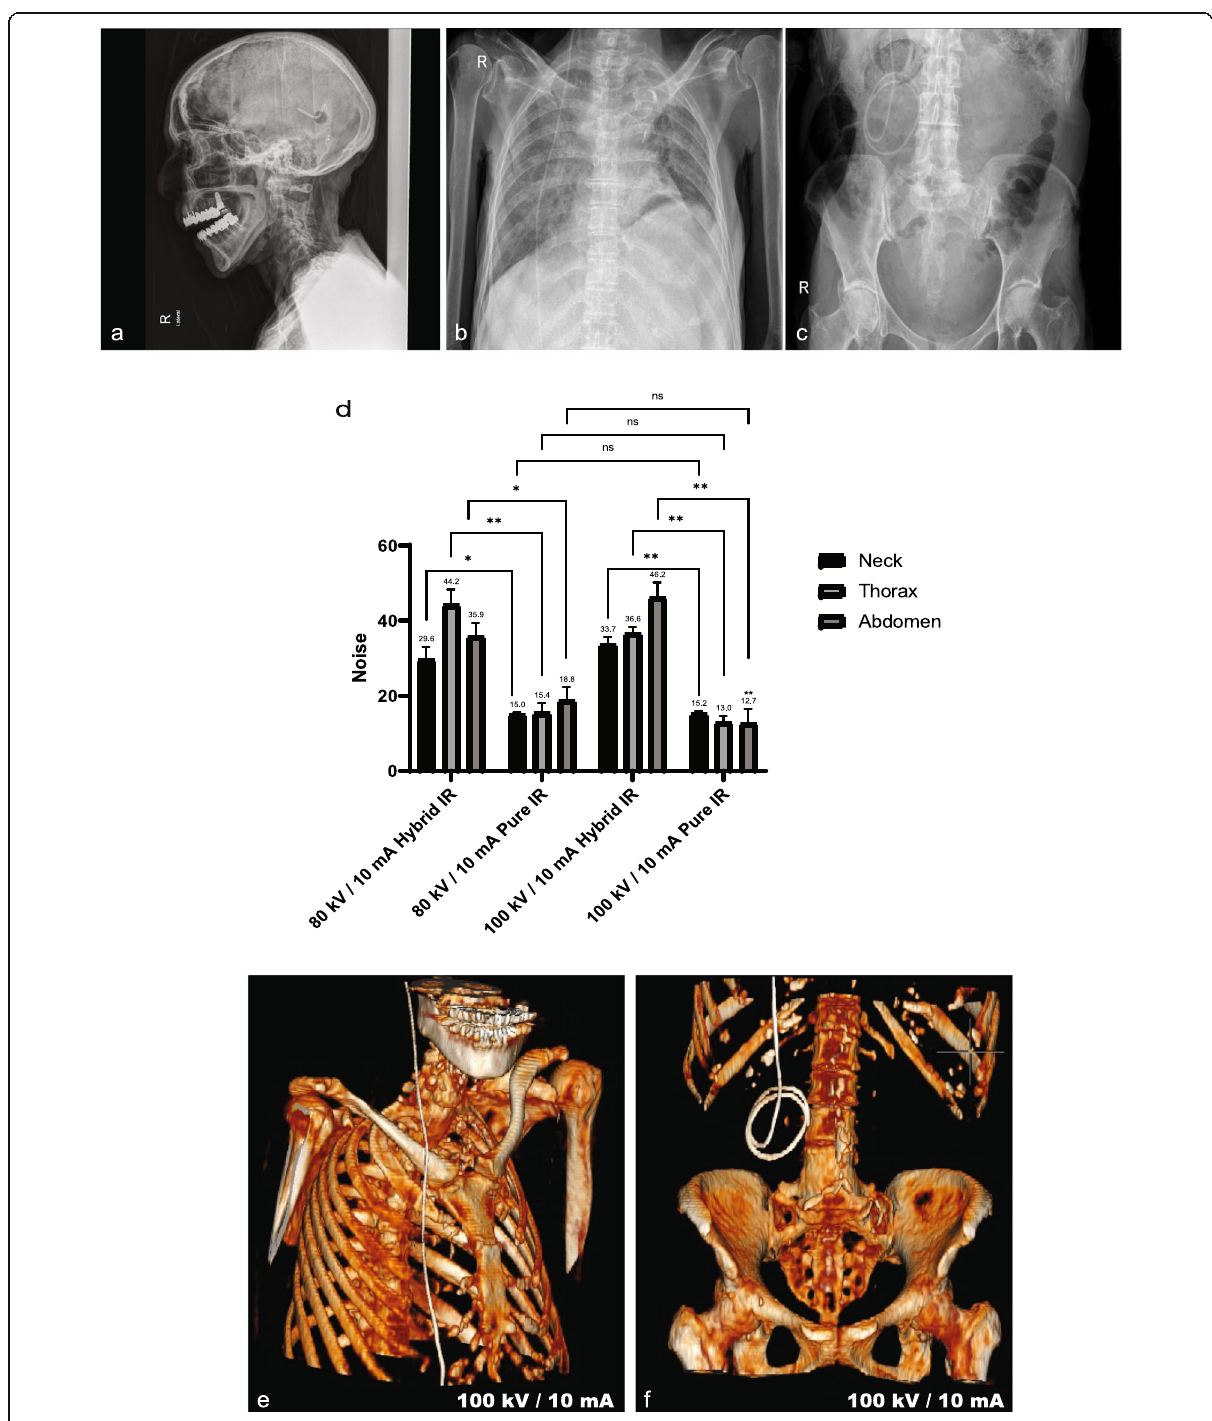
Fig. 2 Phantom- and cadaver-based computed tomography protocol development. Plain radiographic shunt series confirming appropriate positioning of the de novo inserted ventriculoperitoneal shunt ( a – c ). Objective image noise values for the neck, thorax, and abdomen using two kVp/mA settings (80/10 and 100/10) reconstructed using hybrid IR and pure IR ( d ). Data represent mean and standard deviation. Difference in means at each anatomical level was assessed using paired sample t -tests. For comparisons of hybrid IR and pure IR at 80/10 (neck: * p = 0.019; thorax: ** p = 0.003; abdomen: * p = 0.013) and 100/10 (neck: ** p = 0.002; thorax: ** p = 0.004; abdomen: ** p = 0.007). There was no significant difference (ns) in image noise between pure IR images acquired at 80/10 or 100/10. ( e ) Three-dimensional reconstruction demonstrating the ventriculoperitoneal shunt at the final protocol setting